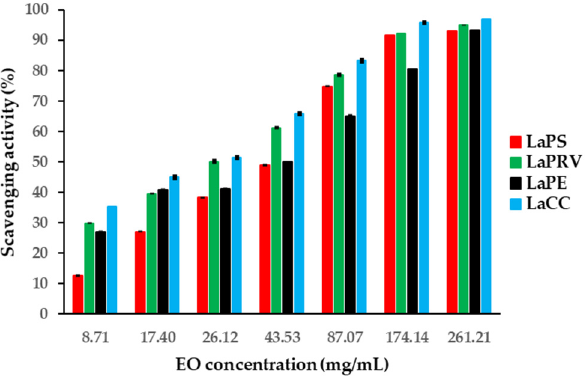
Figure 4. Scavenging effect on four L. angustifolia EOs on DPPH assays at different concentrations ranging from 8.71 mg/mL to 261.21 mg/mL. Data are expressed as mean values ± SE ( n = 3).